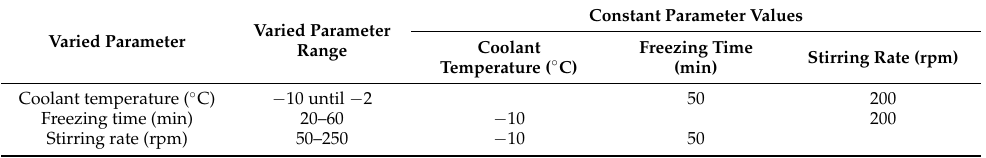
Table 2. Values of varied and constant parameters in oily kitchen wastewater recovery. Varied Parameter Varied Parameter Range